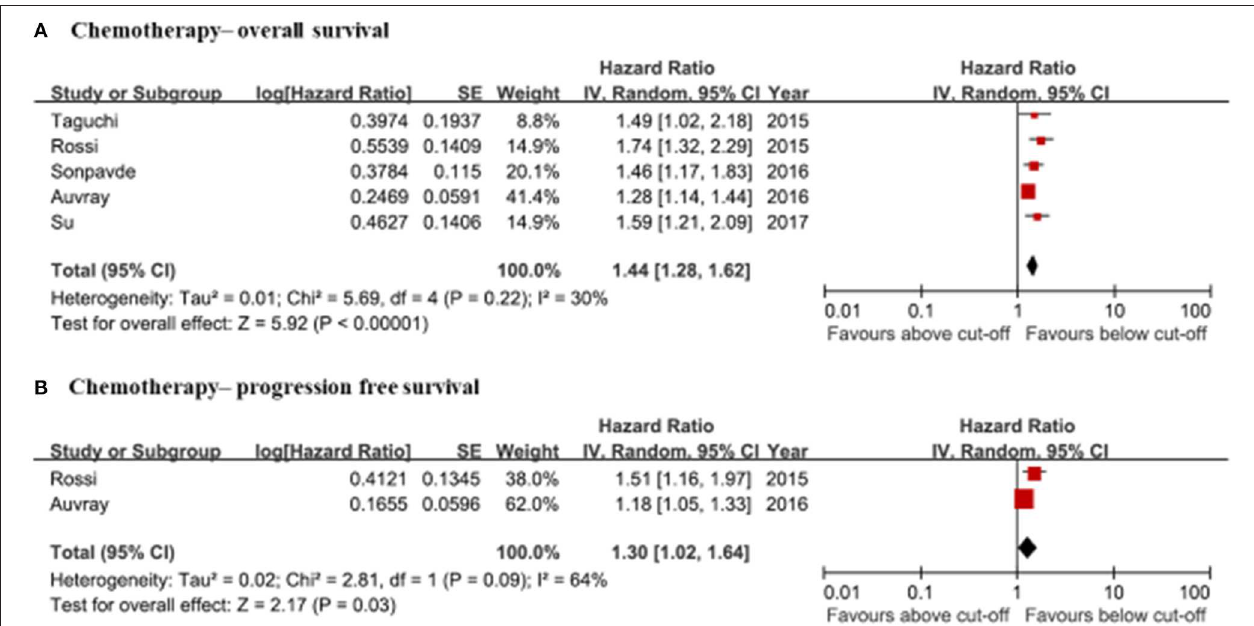
FIGURE 5 | Forrest plots of the relationship between NLRs and clinical information in chemotherapy patients. (A) Chemotherapy—overall survival. (B) Chemotherapy—progression free